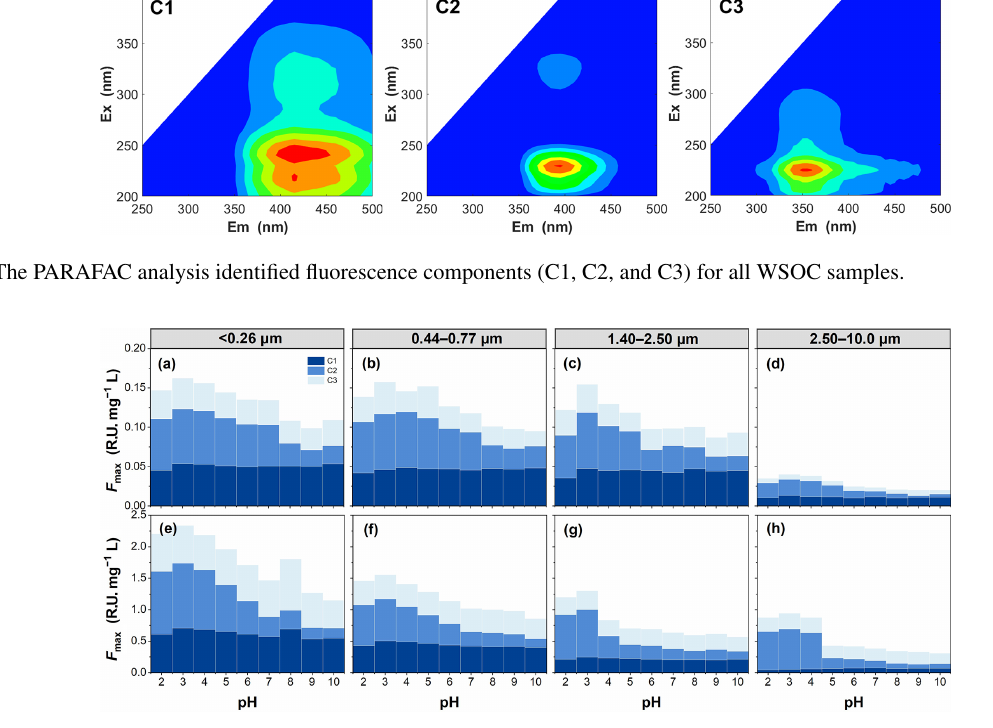
Figure 9. pH dependence of the F max of fluorescence components for WSOC in particles of different sizes in summer (a–d) and winter (e–h) in the pH range of